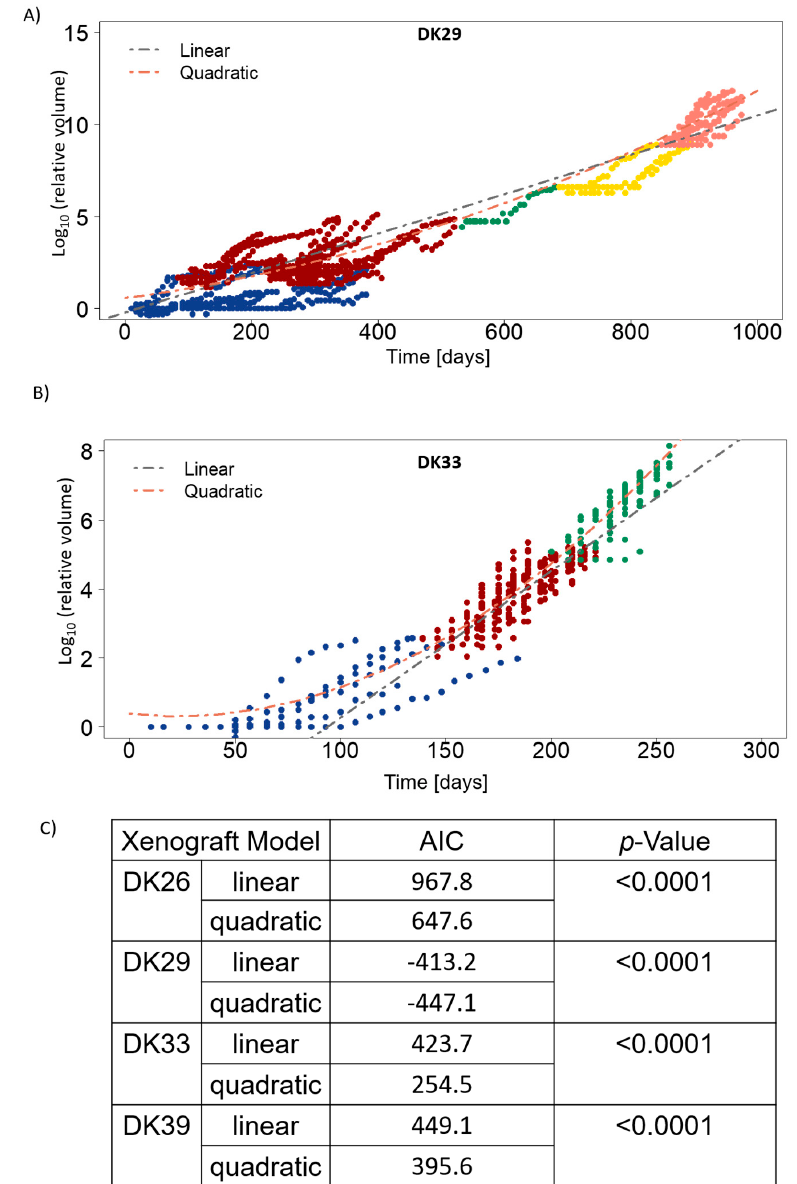
Figure 4. Figure 4. The growth rate of the PDXs increases over time. ( A ) Cumulative growth curve in DK29, which was serially transplanted for five passages. ( B ) Cumulative growth curve in DK33, which was serially transplanted for three passages. The linear and quadratic model fits are represented as dotted lines. Each dot represents a tumour measurement of a growing tumour. Blue: passage one; red: passage two; green: passage three; yellow: passage four; pink: passage five. ( C ) Results of the ANOVA analysis, which was used to compare the two models (linear and quadratic) with R. AIC: Akaike Information Criterion. The model with the lowest AIC is considered the best-fitting